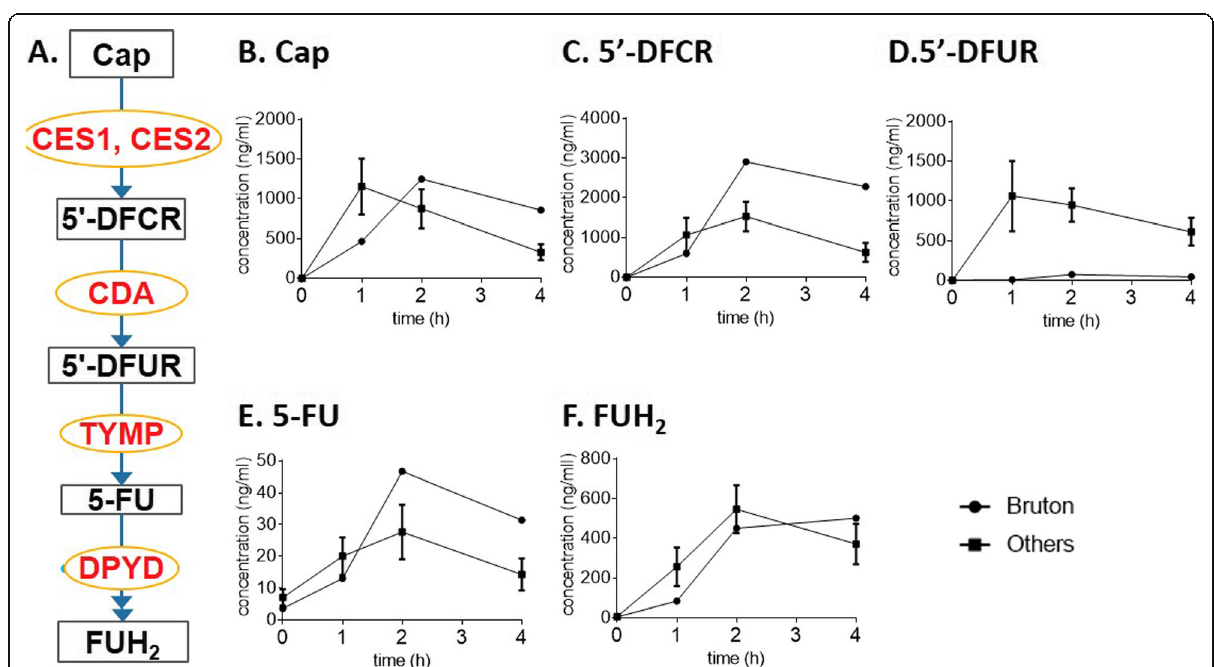
Fig. 2 Therapeutic drug monitoring on Cap and its metabolites. a A simplified metabolic pathway of Cap. Metabolites and enzymes are indicated in black and red, respectively. Plasma concentrations of Cap ( b ) and its metabolites 5 ′ -dFCR ( c ), 5 ′ -dFUR ( d ), 5-FU ( e ), and FUH 2 ( f ) were measured before and 1 – 4 h after the administration of Cap. The concentrations are presented as the mean ± SEM. Abbreviations: Cap, capecitabine; 5 ′